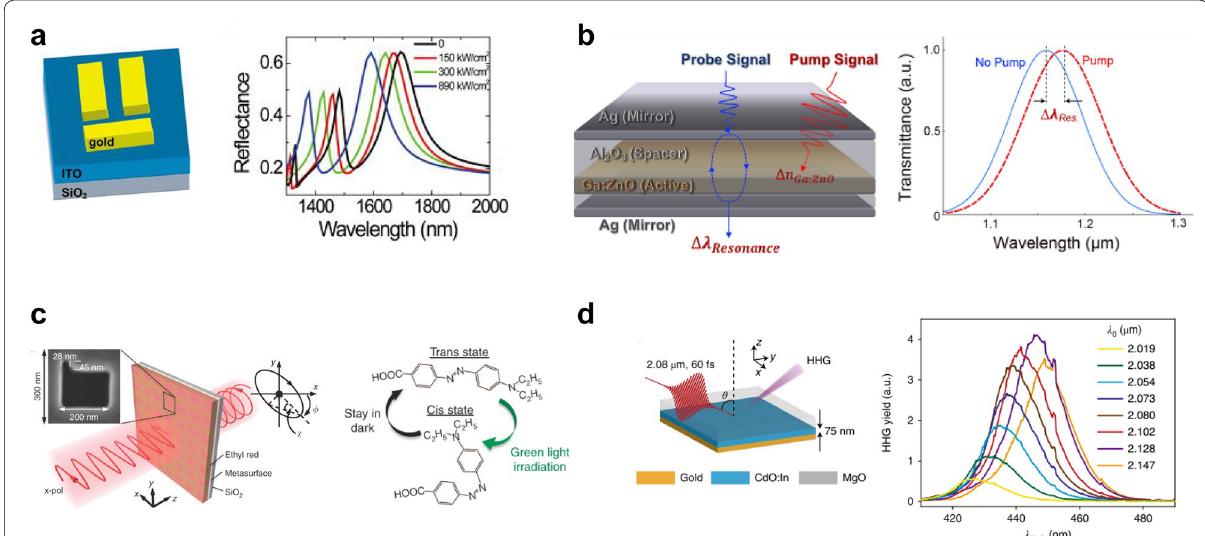
Fig. 4 Nonlinear‑optically tunable metasurfaces. a Plasmonic‑antenna assisted tunable meta‑atom by Kerr nonlinearity [69]. Reproduced with permission from ©2013, Springer Nature. b Optical pumping leads to Fabry‑Pérot resonance shift owing to the large nonlinearity of a nanocavity [70]. Reproduced with permission from ©2018, American Chemical Society. c Polarization converter based on molecular transformation [71]. Reproduced with permission from ©2017, Springer Nature. d Fifth harmonic generation from a hybrid oxide heterostructure near ENZ